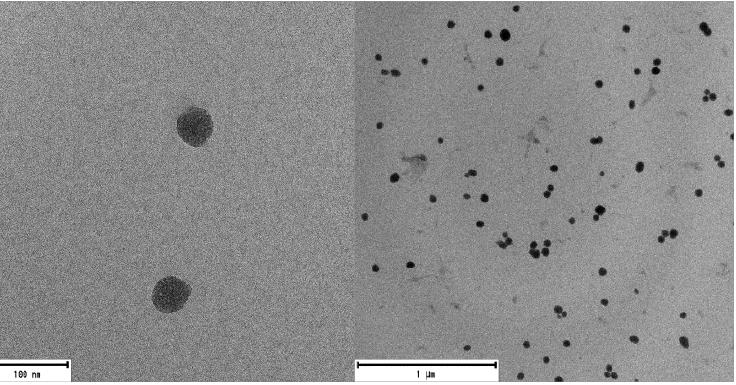
Figure 2. TEM images of MSNs. There are no noticeable differences between any of the synthesized MSNs (NH-MSN, CN-MSN and COOH-MSN). Table 1. DLS and Zeta potential of mesoporous silica nanoparticles in